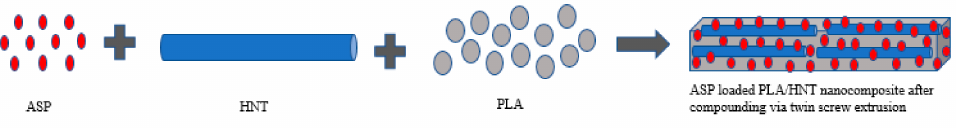
Figure 2. Schematic illustration of PLA / HNTs / ASP nanocomposite by matrix-loading method for batch B2 and B3.